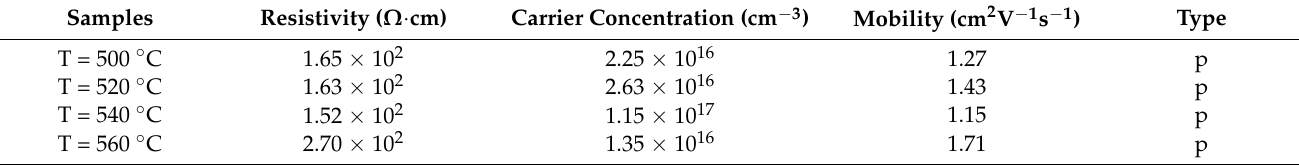
Table 2. Electrical properties of the CNZTSSe films selenized as the selenization temperature of 500 °C, 520 °C, 540 °C, and 560 °C.